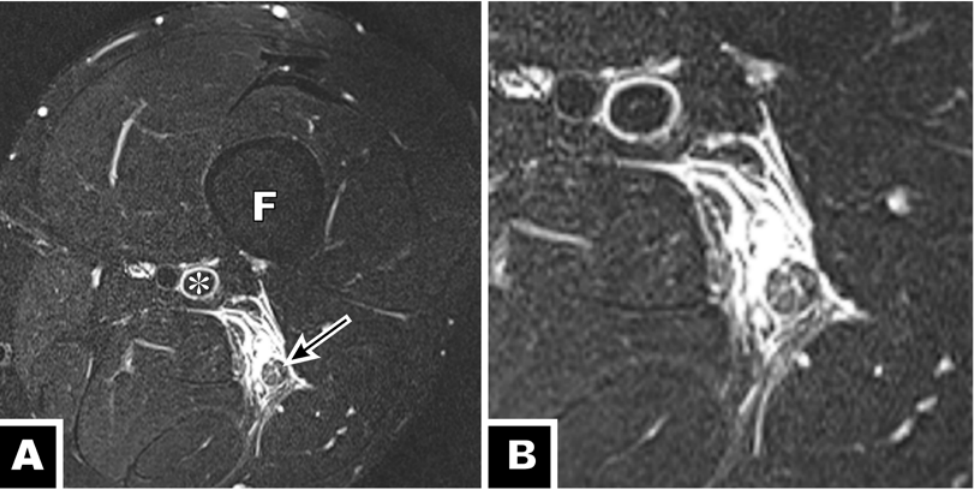
Figure 2: Post-block MRI-scan showing intrafascicular fluid accumulation inside the sciatic nerve A: MRI-scan (T2, TSE, SPAIR, axial plane) with signs of intrafascicular fluid accumulation just proximal to the bifurcation of the SN (indicated by arrow) of a patient with sonographic evidence of intrafascicular injection (* popliteal artery; F, femur). Note the persisting amount of hyperintensive fluid around the SN. B: Enlarged detail view of the SN showing multiple hyperintensive fluid accumulations located intrafascicularly (compare Figure 3B). The entire circumference of the SN is still surrounded by hyperintensive fluid